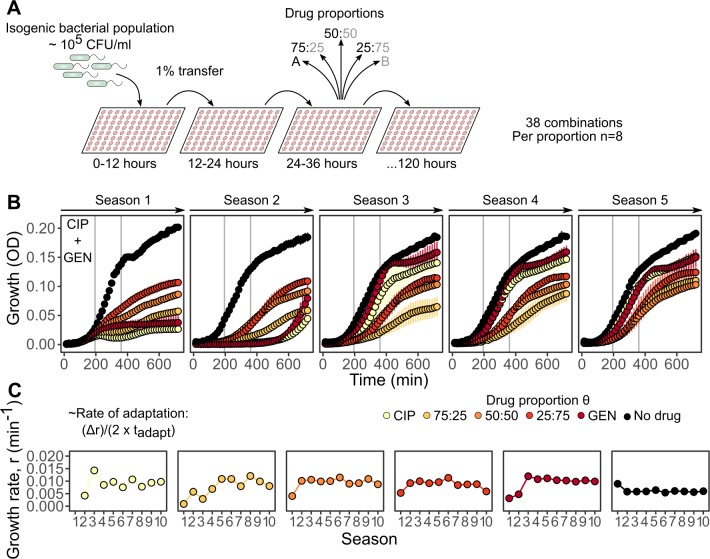
Experimental design and inference of adaptation rates.(A) Schematic representation of the evolution experiment with antibiotic combinations. Thirty-eight combinations were serially transferred every 12 h (season) into fresh medium containing antibiotics mixed in 5 different proportions (n = 8 per proportion and drug combination). An uninhibited control was also included, replicated 4 times, resulting in a total of 44 populations per combination and 1,672 for all combinations. Single-drug treatments of any drug A and B aimed at inhibiting 75% of growth relative to a drug-free environment (i.e., IC75). (B) An example of the quantitative growth measures obtained for a particular combination (CIP plus GEN) and the various drug proportions. Each panel shows 1 out of 5 seasons of growth (measured with OD as a proxy ± SD) over a 12-h period. Vertical grey lines denote the time window from which the slope was calculated to infer the growth rate r of each evolving population during exponential growth. All the drug proportions considered are highlighted in different colors (yellow to red), as well as the no-drug control (black). (C) Six exemplary populations from the CIP plus GEN combination experiments illustrating the change in growth rate r over 10 seasons of growth for each of the drug proportions. The rate of adaptation was calculated following previous work [16], and as indicated on the left of panel C, tadapt is defined as the time required to reach half of the change in growth rate, Δr. The data for this figure are provided in S4 Data. CFU, colony-forming unit; CIP, ciprofloxacin; GEN, gentamicin; OD, optical density; IC75, concentration inhibiting 75% of bacterial growth.